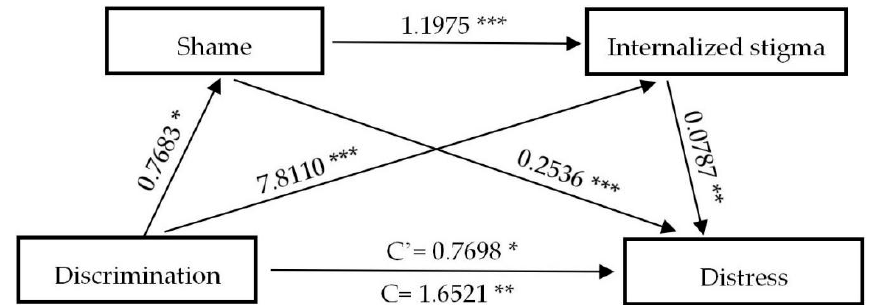
Figure 1. A serial mediation analysis of shame and internalized stigma on discrimination to anxiety. * p < 0.05, ** p < 0.01, *** p < 0.001. C: direct effect without mediators; C’: direct effect with the mediators of shame and internalized stigma.